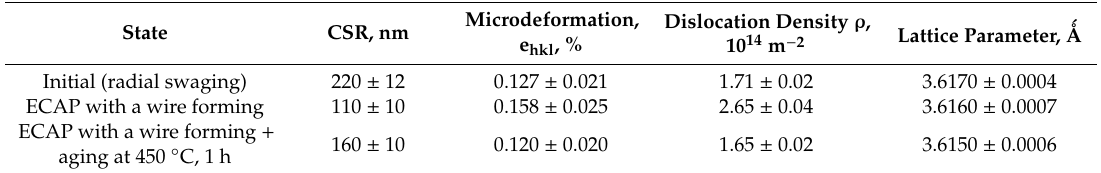
Table 1. X-ray structure analysis.